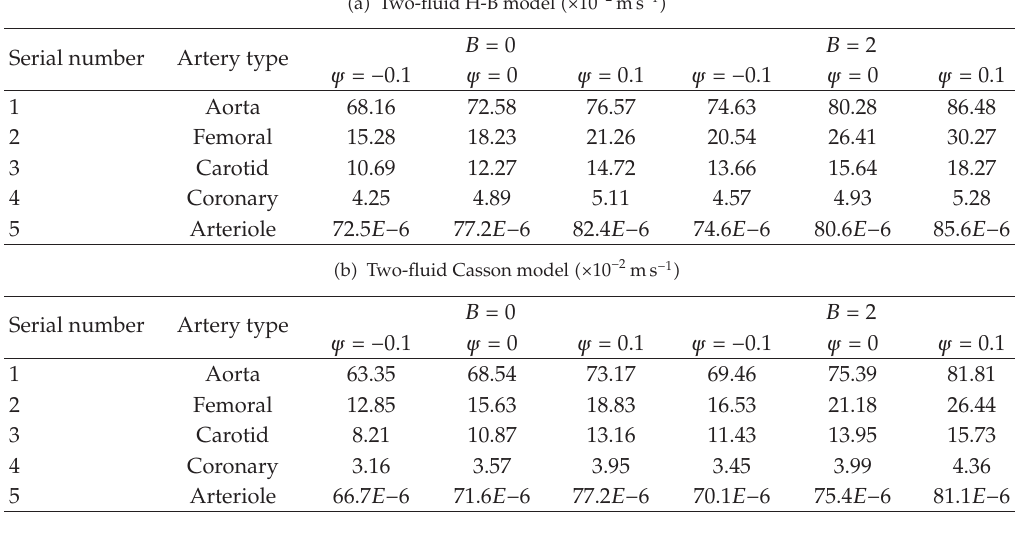
Table 4: Estimates of mean flow rate of two-fluid H-B and Casson models for di ff erent values of m and B in arteries with di ff erent radii with t (cid:7) 60 ◦ , β (cid:7) n (cid:7) 0 . 95, θ (cid:7) δ P (cid:7) 0 . 1, φ (cid:7) α (cid:7) α H (cid:7) α C (cid:7) 0 . 2, z (cid:7) 2 . 3, e (cid:7) 0 . 5, ω (cid:7) 1, and b (cid:7) 0 .